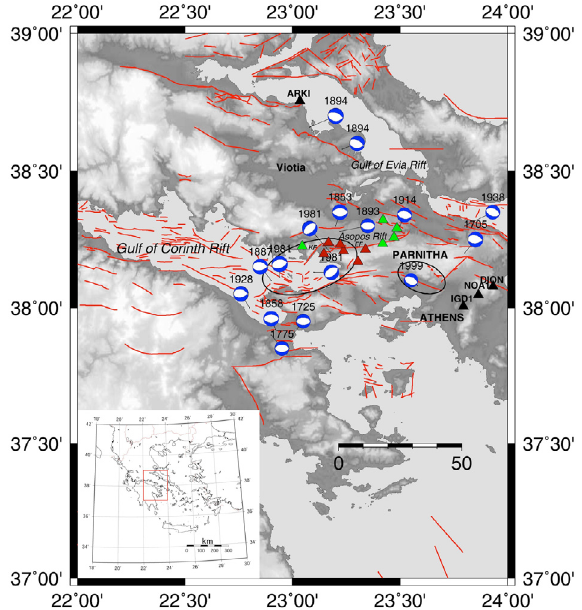
Figure 1. Relief map of Attica, the eastern Gulf of Corinth and Vi- otia region, central Greece (see lower left inset box for location). Beachballs indicate focal plane solutions of large, shallow earth- quakes since 1853 (blue indicates compressional quadrant). Black ellipses are ruptures zones of the 1981 and 1999 earthquakes. Solid triangles represent locations of the Kaparelli GPS network (red in- stalled in 2003 and green in 2005) and permanent stations (in black). Red lines are active faults. KF is Kaparelli Fault. EF is Erithres